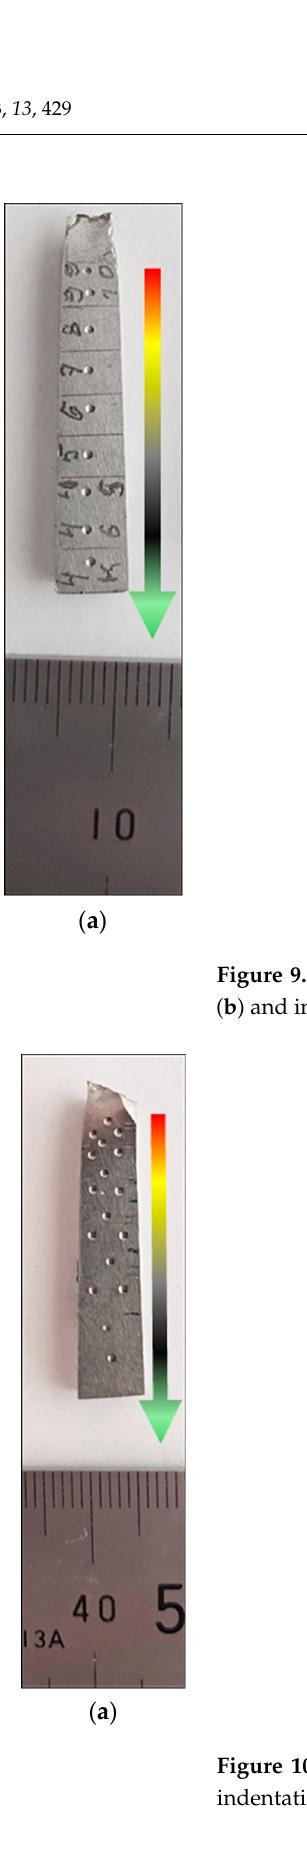
( b ) Figure 11. LCF tested specimen: ( a ) gage part of the specimen after indentation tests; ( b ) and indentation force–displacement plots.